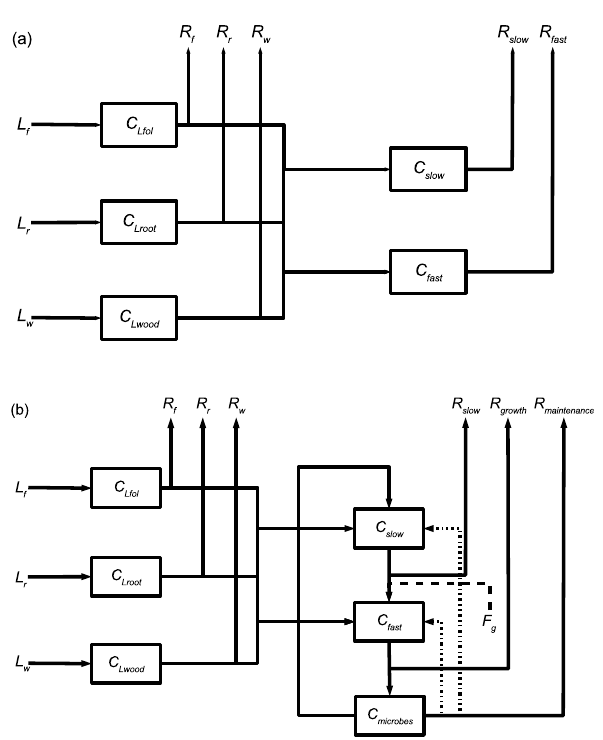
Figure 1. Model diagram for (a) the chemical and (b) the biological model. Boxes represent pools, arrows with solid lines fluxes and arrows with dotted lines influence of a variable on a process. F g (gCm − 2 h − 1 ) represents the input of glucose exudates for the litter quality